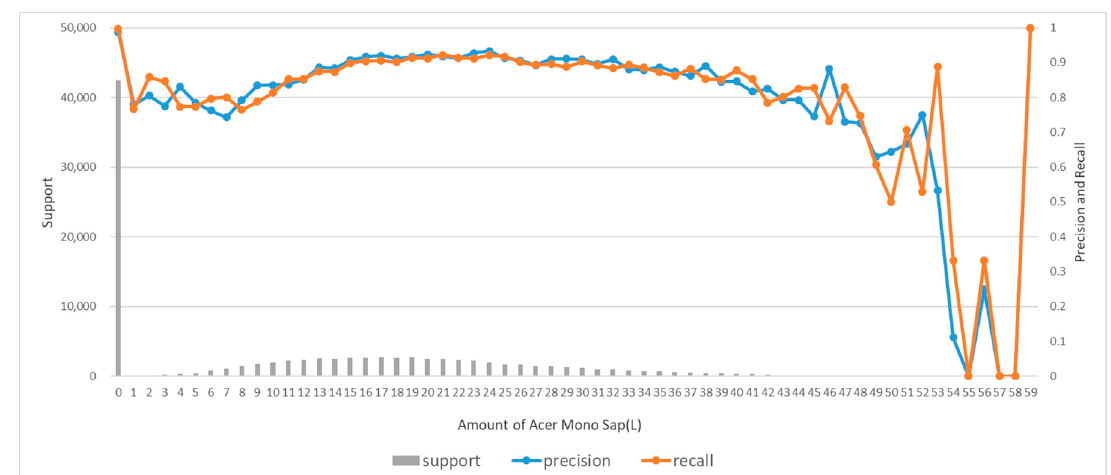
Figure 17. Prediction accuracy of SVM optimal model.